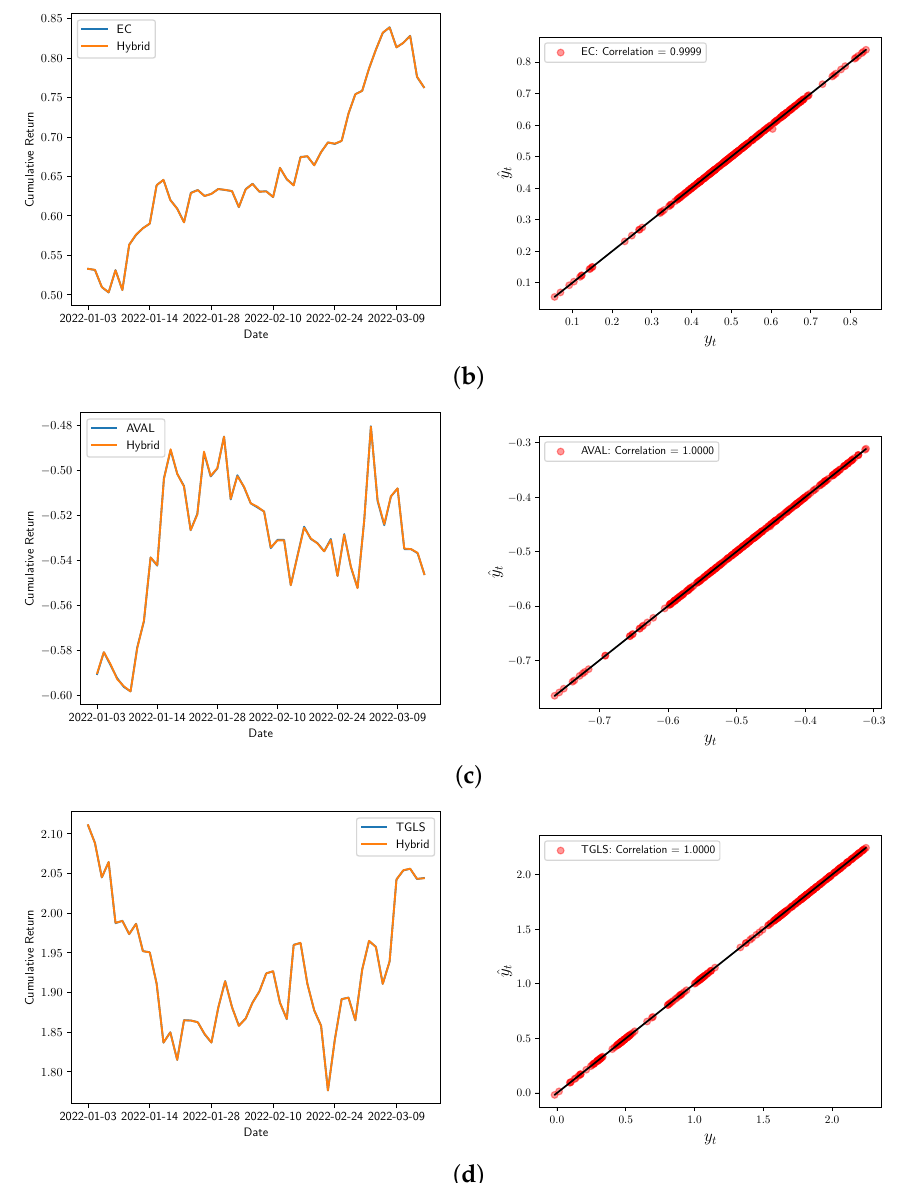
Figure 8. Real vs. Hybrid adjustment for the cumulative returns (left) and correlation Corr ( y t , ˆ y t ) for the real and forecasted share prices (right) of: ( a ) Bancolombia, ( b ) Ecopetrol, ( c ) Grupo AVAL, and ( d )